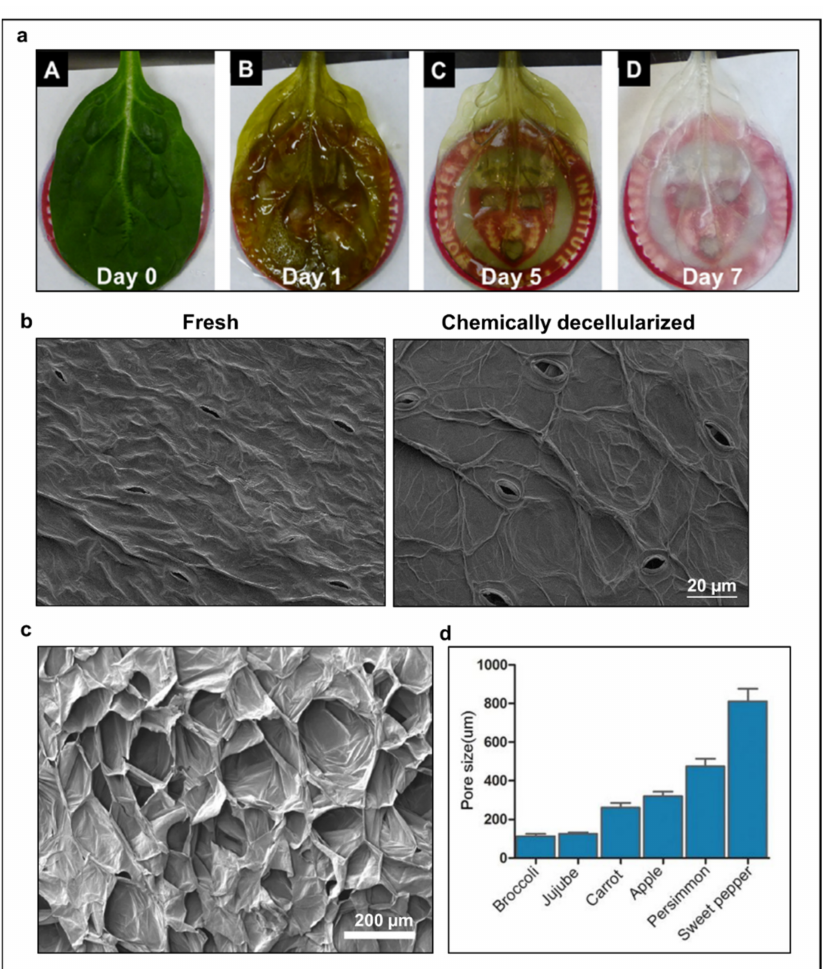
Figure 1. ( a ) Spinach leaf decellularization by serial chemical treatment. Perfusion of sodium dodecyl sulfate (SDS) causes the leaf to lose chlorophyll, while the bleach solution is used to remove any residual plant content and flush debris from the scaffold. Reproduced from Gershlak et al. [34]. ( b ) To visually demonstrate decellularization efficiency, scanning electron microscopy (SEM) images of fresh and chemically decellularized spinach leaf scaffolds revealed that the fullness of the fresh leaf was lost after decellularization. Cells were removed, revealing micro-vessel ultrastructure and plant features such as the cell wall and guard cells of the stomata. Data generated by authors for illustrative purposes for this review. ( c ) SEM images of scaffold architecture reveal decellularized apple tissue generates a three-dimensional scaffold. Reproduced from Modulevsky et al. [32]. ( d ) Various decellularized vegetal tissues’ pore size found in the ideal range for TE. Reproduced from Lee et al.